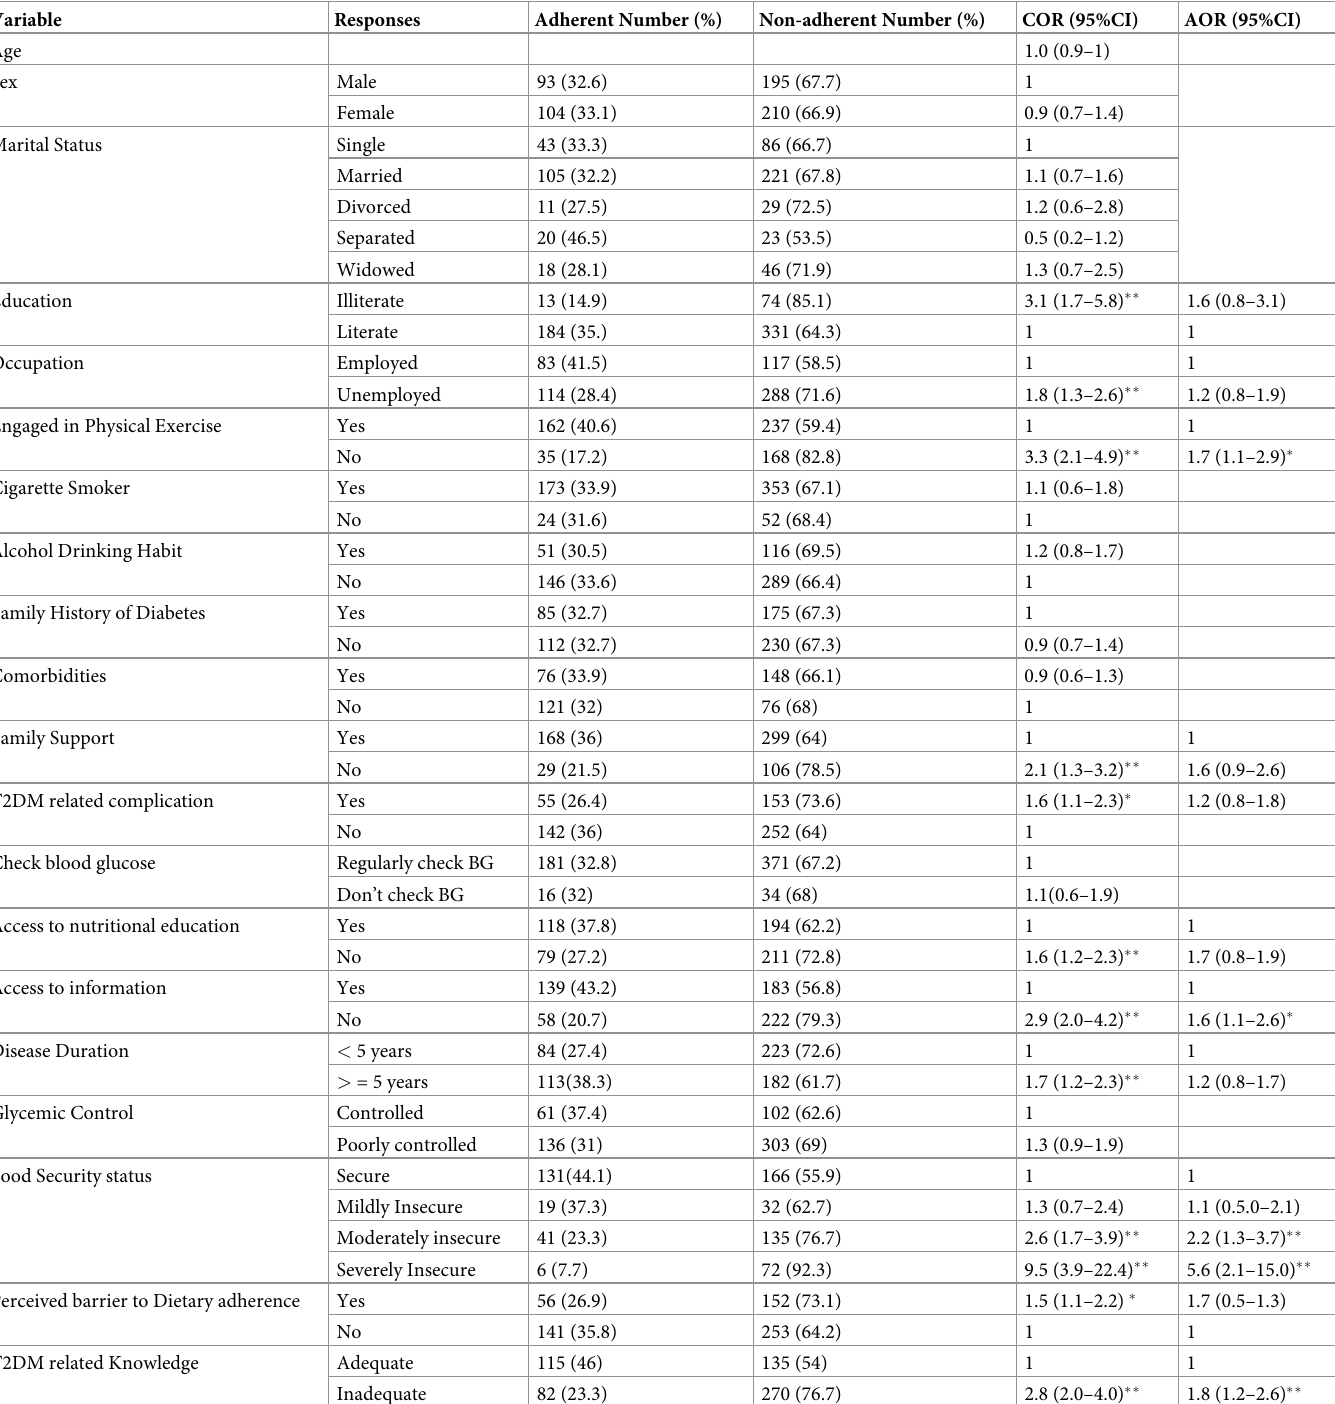
Table 4. Factors associated with nonadherence to dietary counselling of patients with T2DM who had regular medical check-ups at selected public hospitals in Addis Ababa,